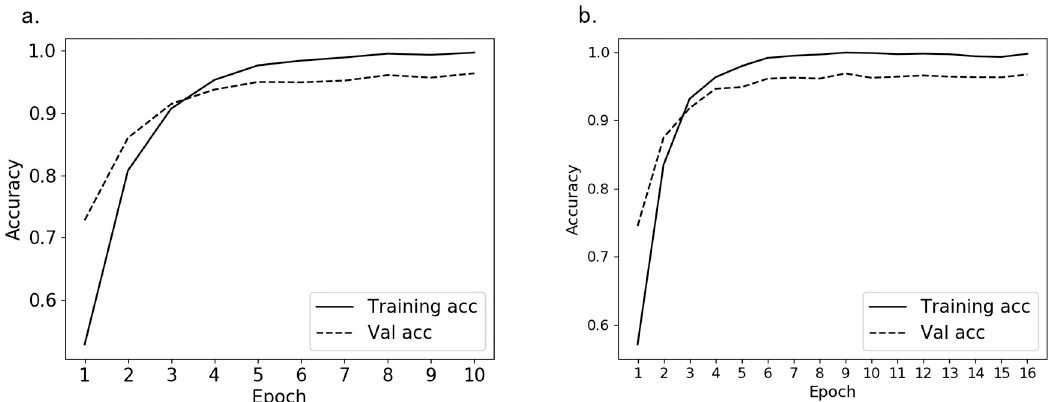
Figure 9. The accuracy of the training set and validation set in the training process; ( a ) the accuracy of training 10 epochs change; ( b ) the accuracy of training 16 epochs change.